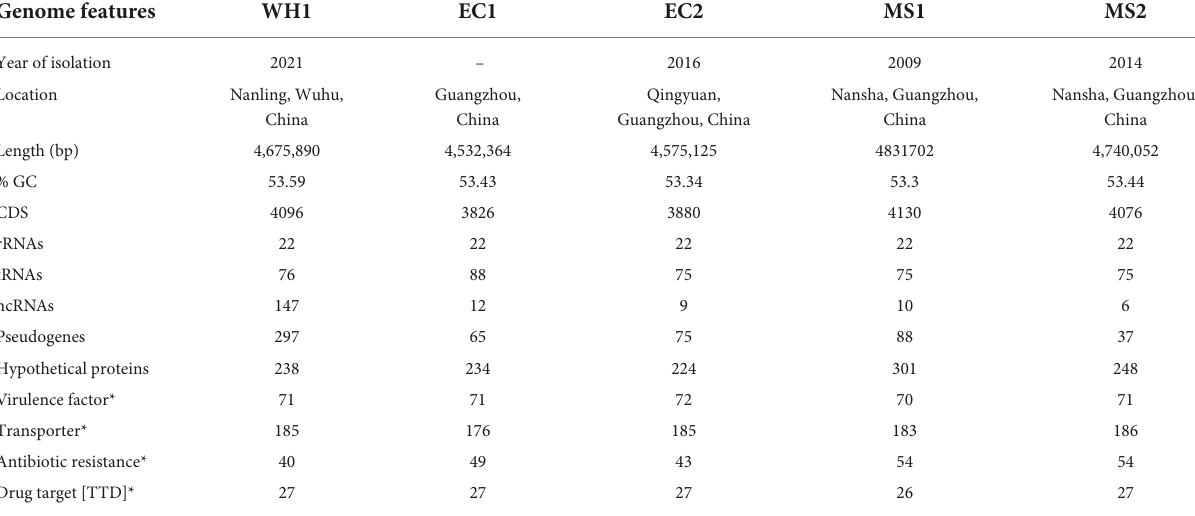
TABLE 2 General genomic information for five Dickeya zeae strains isolated from rice and banana.